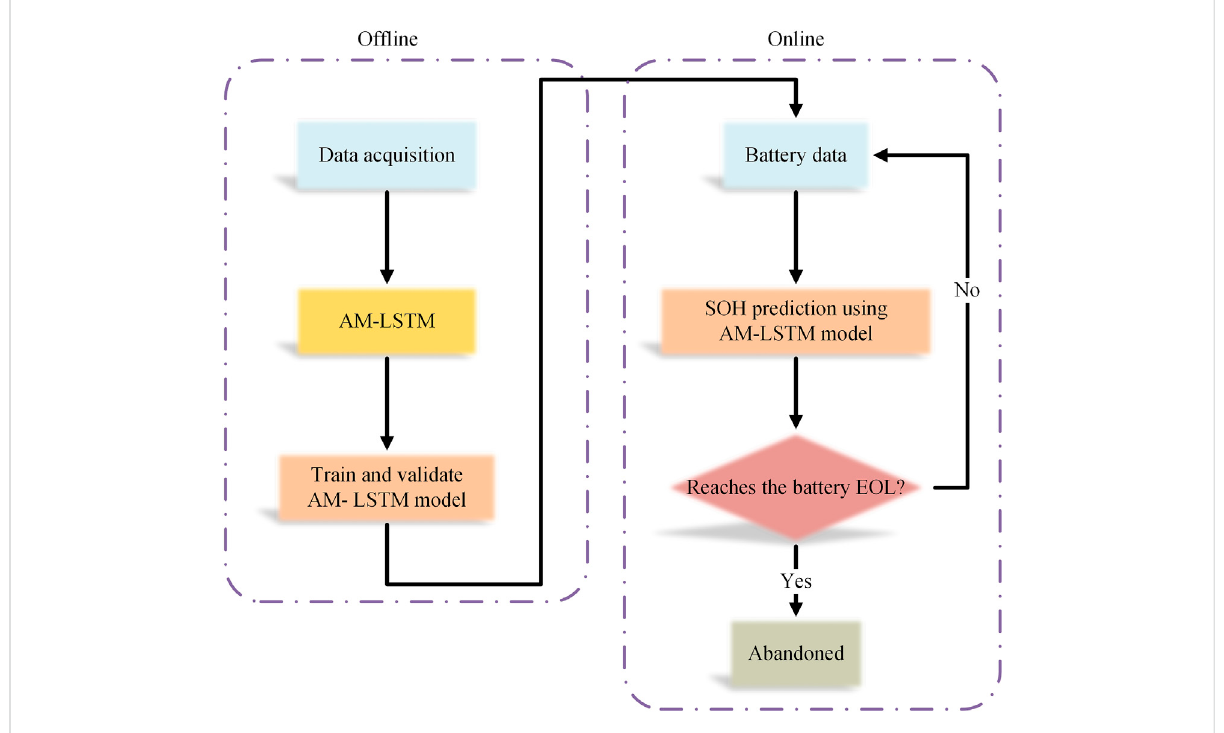
FIGURE 4 The fl owchart of the SOH prediction based on the AM-LSTM